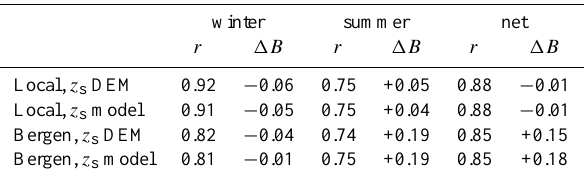
Table 3. Linear correlation coefficient r and the mean annual dif- ference between modelled and measured winter, summer and net mass balance 1B (mw.e.) for Rembesdalsskåka over the period